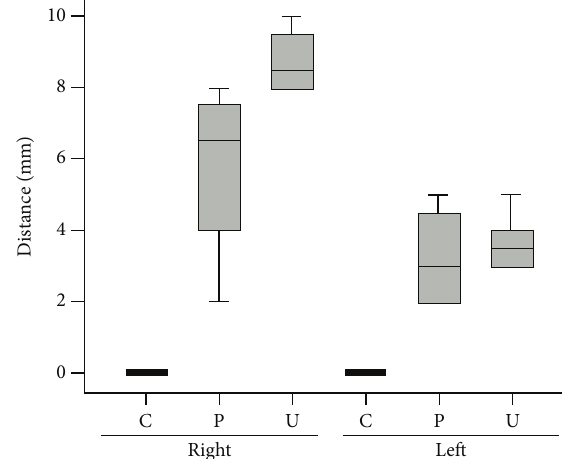
Figure 2: Distance between the subclavius muscle and the subcla- vian vein in each group on the right and left sides. A significant difference was found comparing the distance from the subclavius muscle to the subclavian vein among the three groups based on the subjective classification. C: tightly connected group, P: partly connected group, and U: unconnected group.